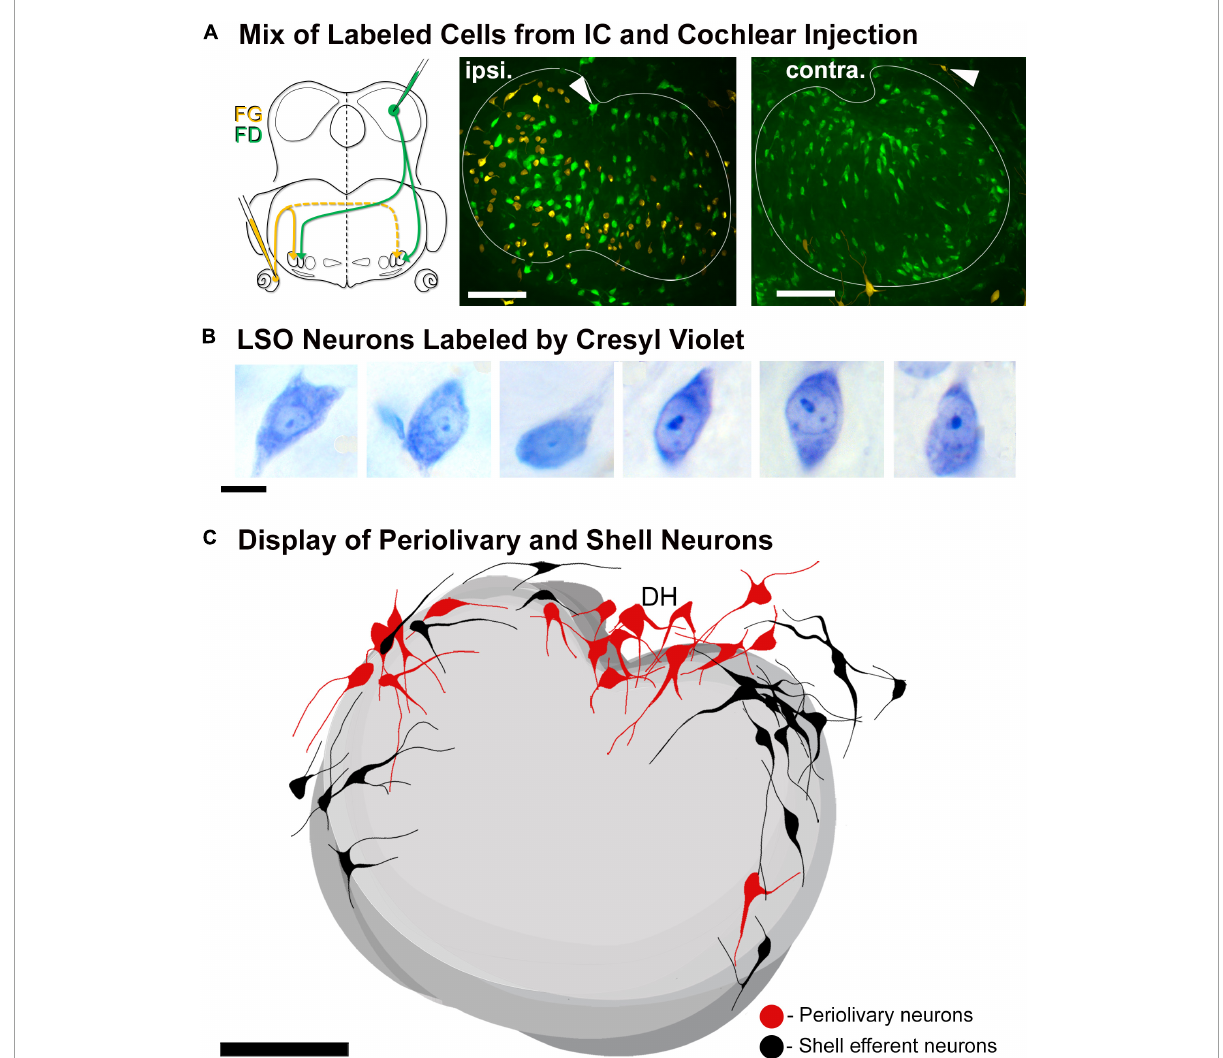
FIGURE4 Double injection of retrograde tracers into the right IC and left cochlea to label the LSO neurons with ascending projections and LOC efferents with descending projections, respectively. LSO neurons with ascending and descending projections were labeled via tracer injections of FD into the right CNIC and FG into the round window of the left cochlea, respectively. (A) Schematic illustration of the injection sites and pathways for the projecting neurons. Fluorescent micrograph showing the left LSO containing labeled contralateral principal neurons (FD-green) and ipsilateral LOC efferents (FG-yellow). The LOC efferents were primarily ipsilaterally projecting, with only a few shell neurons projecting contralaterally. Gray arrowheads: PO neurons (green fluorescence) and shell neurons (yellow fluorescence) on the borders of the LSO. (B) Photomicrographs (100x objective) of CV labeled LSO neurons. In tissue stained by CV, we were unable to distinguish principal from intrinsic neurons due to the similarity in size and shape. (C) Summary of location of labeled periolivary and shell neurons around the borders of the LSO. The position of PO (red) and shell (black) neurons are shown collapsed across 18 LSO sections to illustrate their spatial distribution around the LSO. ipsi., ipsilateral; contra., contralateral; FG, fluorogold; FD, fluorescein dextran. Scale bar equals 100 µ m (A,C) , 25 µ m (B)